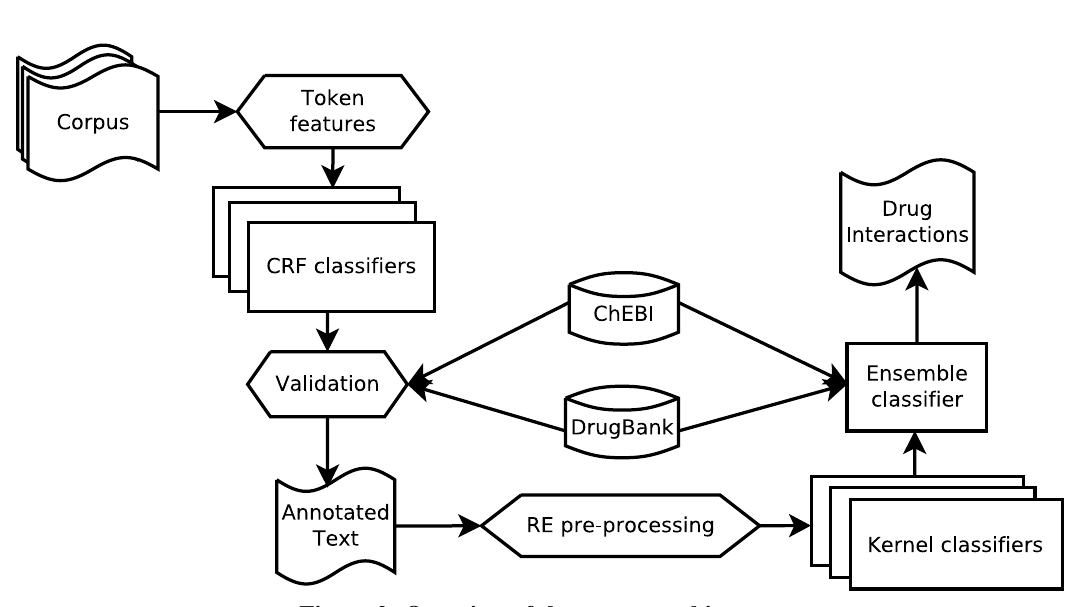
Figure 2: Overview of the system architecture.